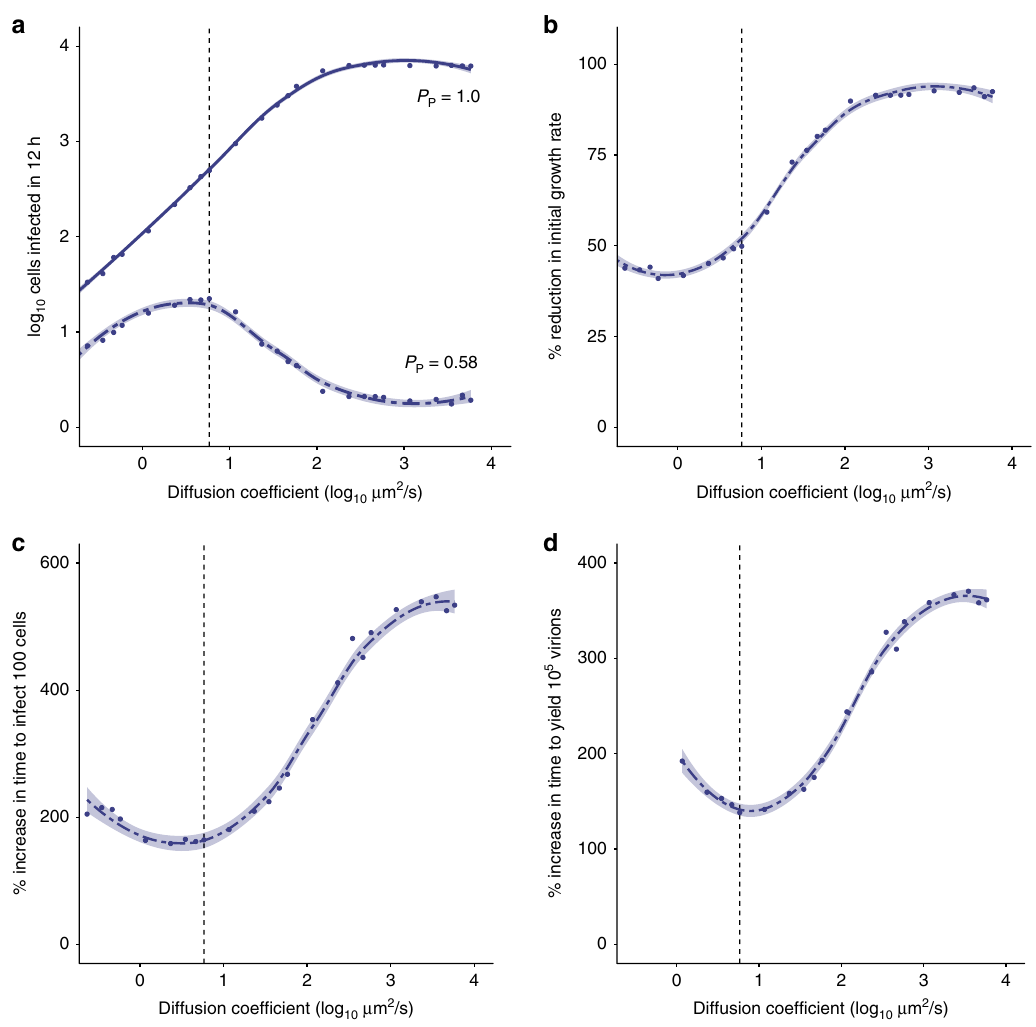
Fig. 4 The fi tness costs of incomplete genomes may be mitigated by spatially structured spread. The dynamics of multi-cycle replication in a 100 × 100 grid of cells were simulated, starting from a single cell in the center of the grid. a The initial growth rate (estimated by the log-transformed number of cells that are productively infected in the fi rst 12 h) is shown across a range of diffusion coef fi cients for a virus with P P = 1.0 (solid line) and P P = 0.58 (dashed line). b – d The fi tness cost of IVGs, as measured by the reduction in initial growth rate ( b ) or the increase in time taken to infect 100 cells ( c ) and produce 10 5 virions ( d ), is shown across a range of diffusion coef fi cients. The vertical dashed line represents the estimated value of D (5.825 µ m 2 /s) for a spherical IAV particle in water. Each point shows the mean of ten simulations. Curves were generated by local regression. Shading represents 95% CI of local regression (mean ± 1.96 * SE). IVGs = incomplete viral genomes. Source data are provided as a Source Data fi